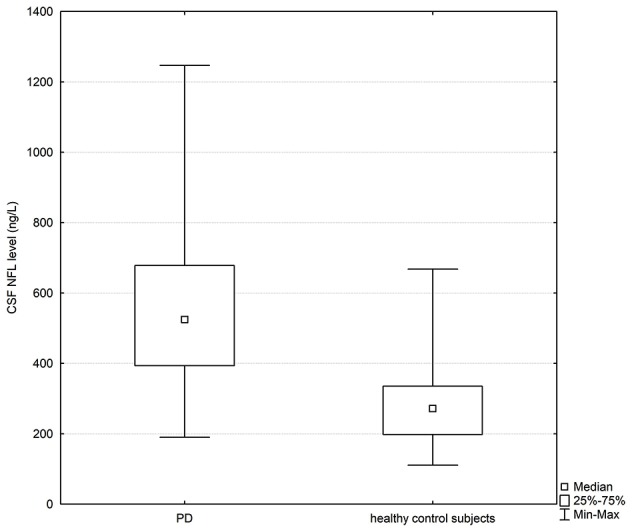
Box plot of cerebrospinal fluid (CSF) neurofilament light (NFL) levels in PD subjects and healthy controls. The central square point in each box indicates the median, box edges mark the first and third quartiles, and limits of the vertical lines show ranges. PD, Parkinson’s disease.